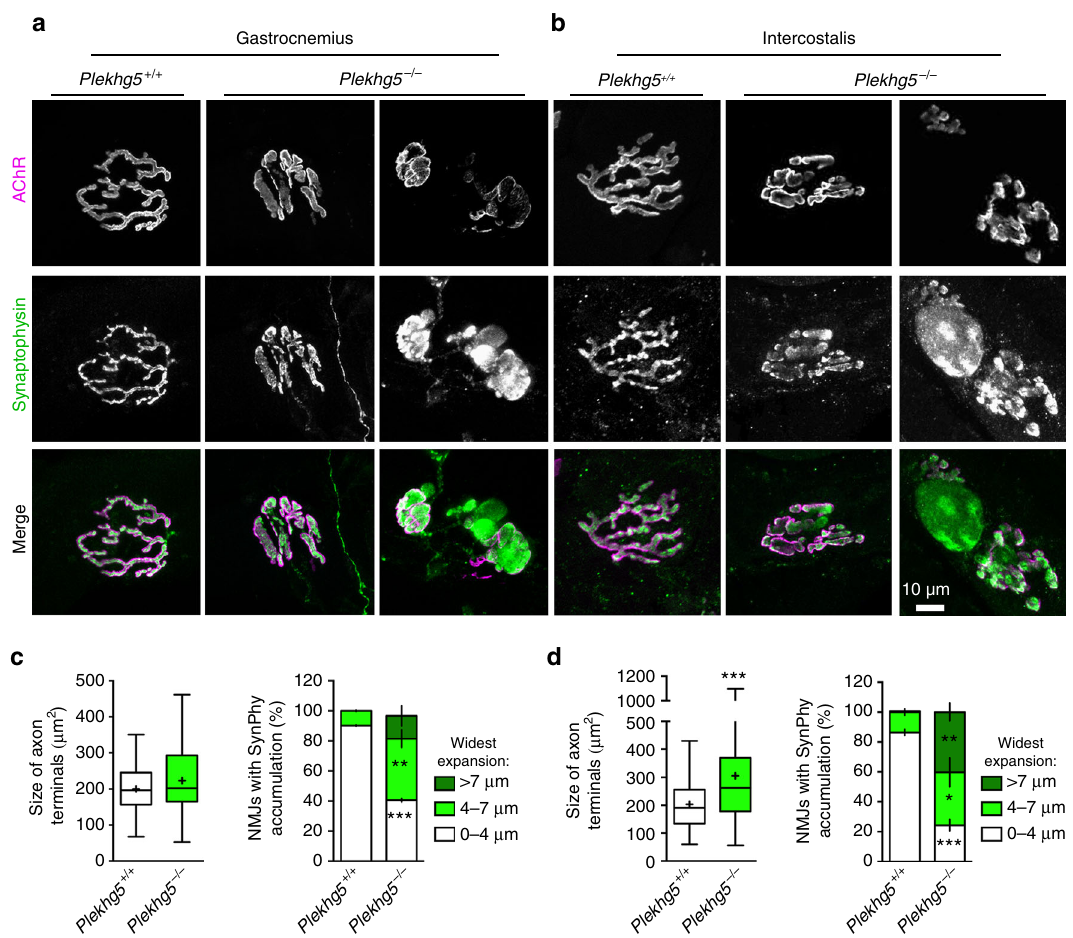
Fig. 2 Degradation of neuromuscular junctions in Plekhg5-de fi cient mice. a , b NMJs within the gastrocnemius a and intercostal b muscles stained for BTX and synaptophysin. Scale bar : 10 µ m. c , d Quanti fi cation of presynaptic area by evaluation of synaptophysin staining and measurement of the widest expansion of presynaptic sites (three animals per genotype with at least 15 NMJs analyzed per animal; mean ± SEM; two-way ANOVA; Bonferroni